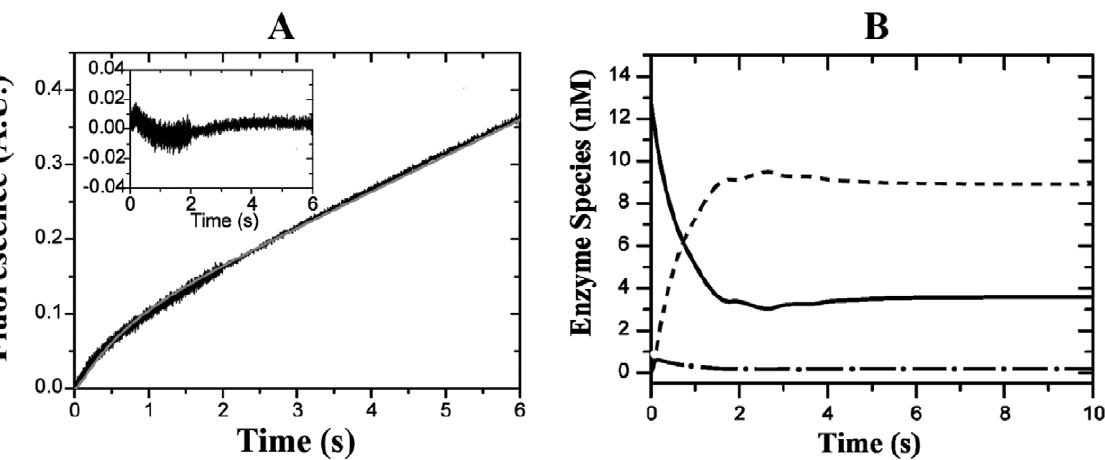
Figure 3. Stopped-flow time-tracesofFRET-peptidehydrolysis by HNE. A , Stopped-flow fluorescence kinetic recording of 3.8 m MFRET- peptide hydrolysis by 12.6 nM HNEat 25 u C in 10 mM Tris-HCl buffer, pH 7.4, containing 100 mM NaCl. The progress of the reaction was monitored by the fluorescence increase of the released product recorded on 2 adjacent time regions with distinct sampling periods: 0.5 ms from 0 to 2 s, 2 ms from 2 to 6 s. Gray solid line represents the best fit obtained from the mechanism depicted in Scheme I in the absence of heparin with the aid of DynaFit IV H software (see Experimental Procedures). The insert graphic represents the associate residual errors from the best fit curve with experimental data. B , the HNE species as a function of time reaction: free enzyme, E ( – ); complex enzyme-substrate, ES (– N – ) and acyl-enzyme, ES’ ( - - - ).